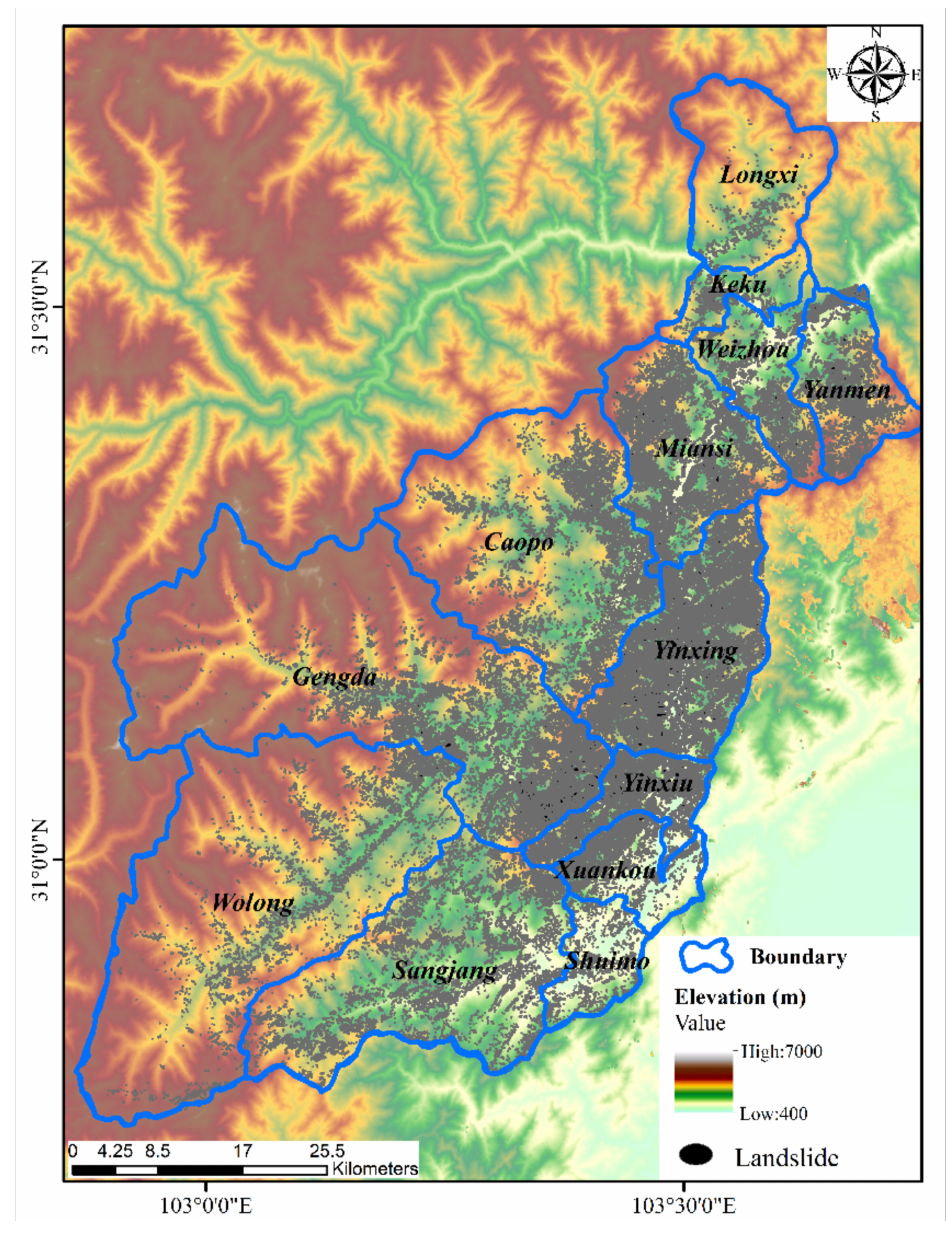
Figure 2. The complete landslide inventory used in this